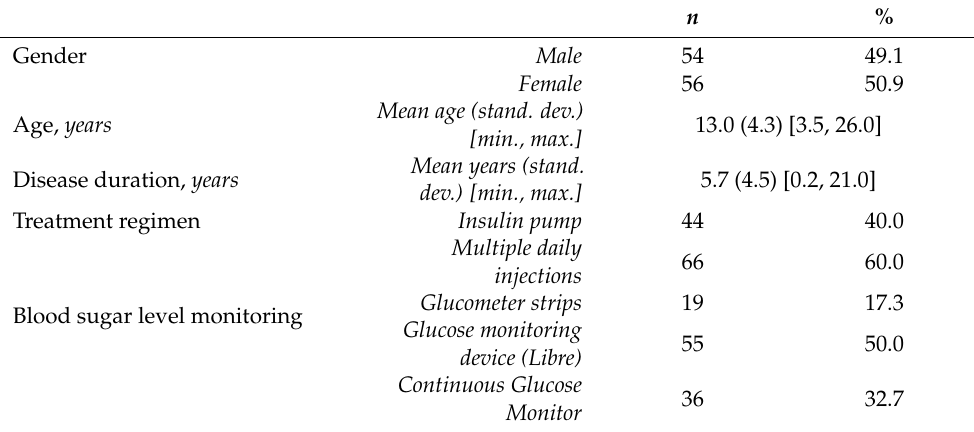
n % Female 56 50.9 Mean age (stand. dev.) 13.0 (4.3) [3.5, 26.0] [min., max.] Mean years (stand.